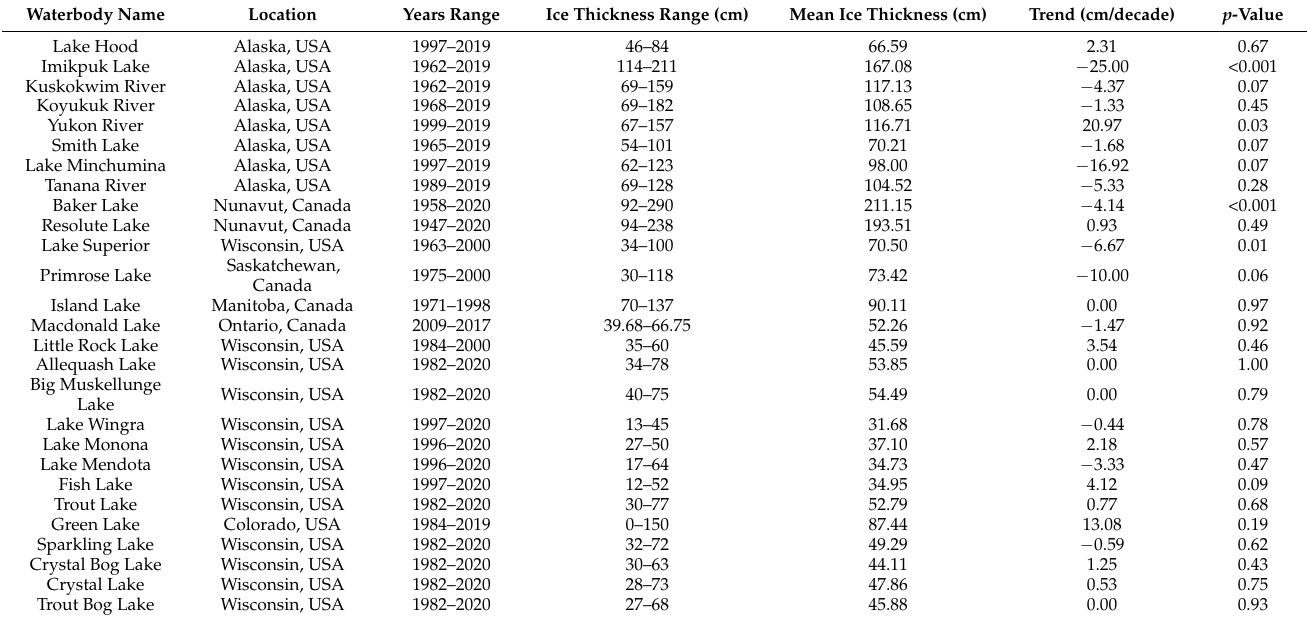
Table 1. Waterbodies with ice thickness data collated in North America. Our study included 23 lakes and 4 rivers across North America, with data starting as early as 1961 and going as far as 2020. We summarized the mean and range in ice thickness, in addition to the trends in ice thickness over time. The trend column shows the slope obtained from the Thiel-Sen estimator, with its associated p -value in the ‘ p -Value’